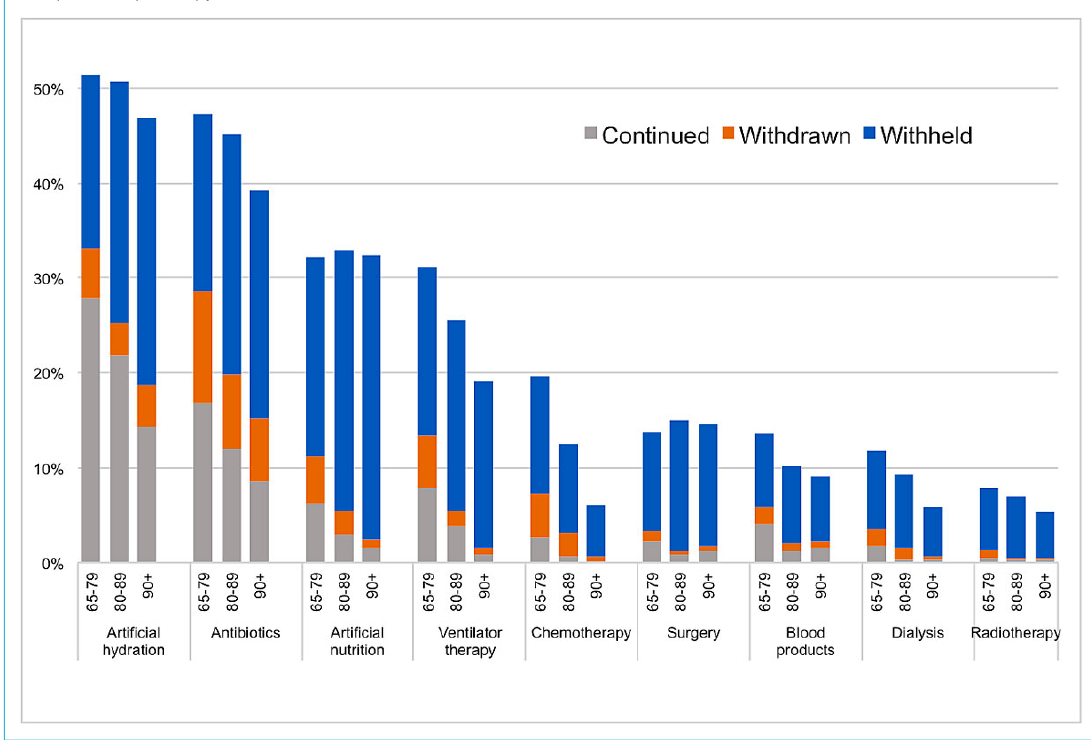
Figure 1: Weighted percentages of cases where treatment was continued, withdrawn, or withheld by age group: 65–79 (n = 835), 80–89 (n = 1242) and 90+ (n = 765) years old.